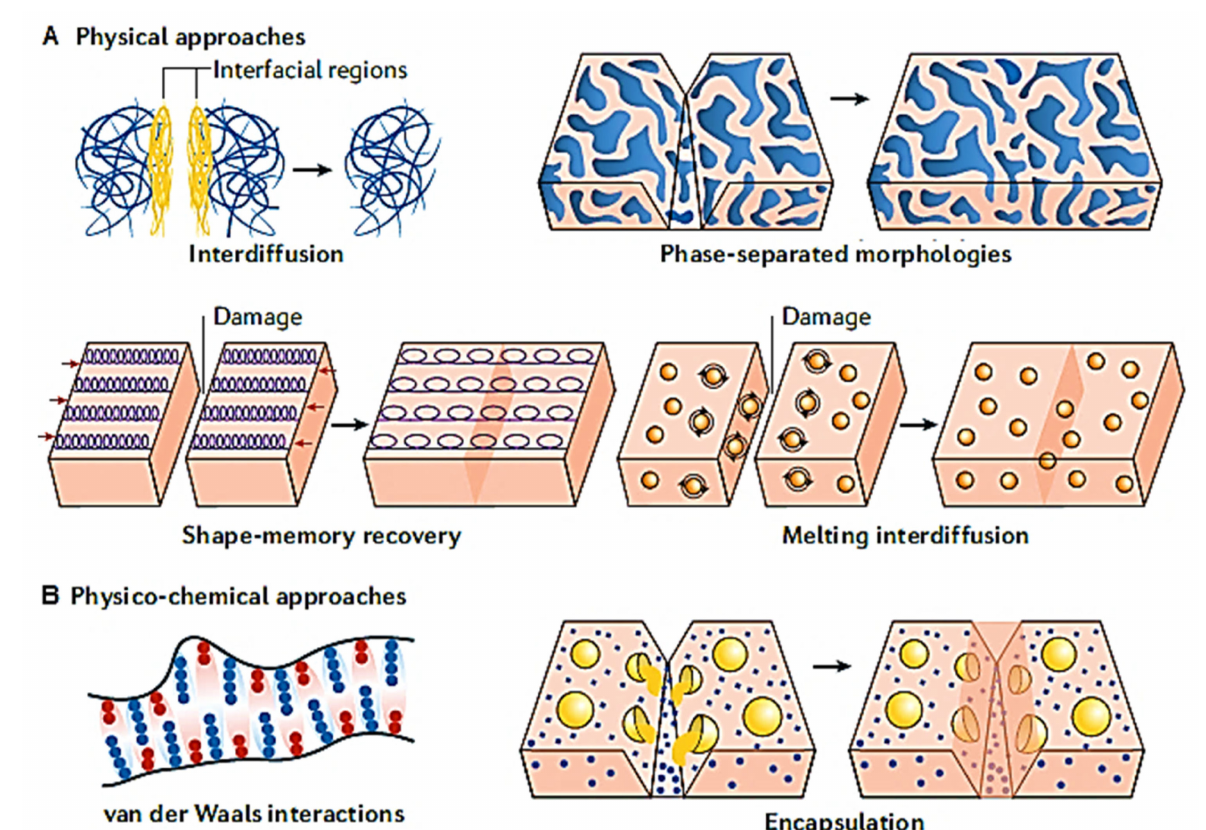
Figure 1. Self-healing mechanisms: ( A ) physical processes to understand self-healing include in- terdiffusion of polymer chains, introduction of phase-separated morphologies, shape-memory and introduction of active nanoparticles into the polymer matrix, and ( B ) physical and chemical processes can be combined to perceive self-healing. Reprinted with permission from [32]. 2020,